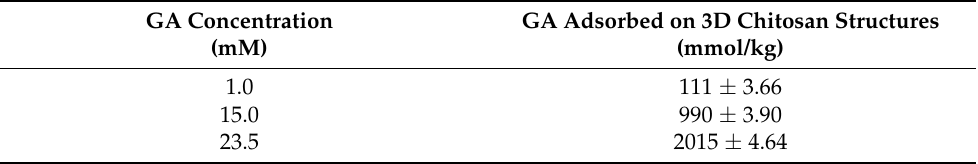
Table 2. Adsorption of GA on 3D chitosan structures at pH 4.0 for an incubation time of 24 h. GA Concentration GA Adsorbed on 3D Chitosan Structures (mM) (mmol/kg) 1.0 111 ± 3.66 15.0 990 ± 3.90 23.5 2015 ±